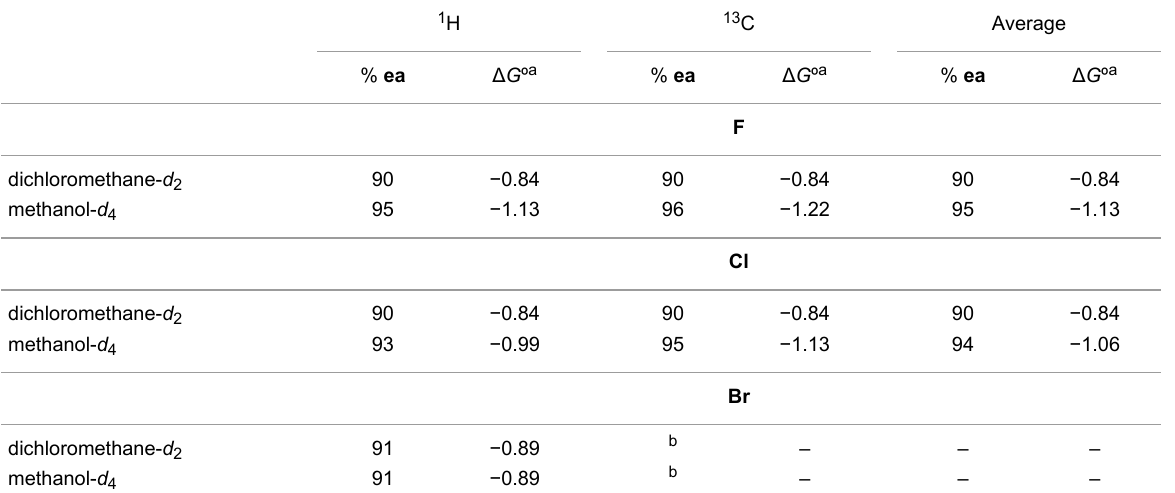
Table 2: Conformational populations and relative conformational energies of cis -2-halocyclohexylamines at − 80 °C in different solvents.